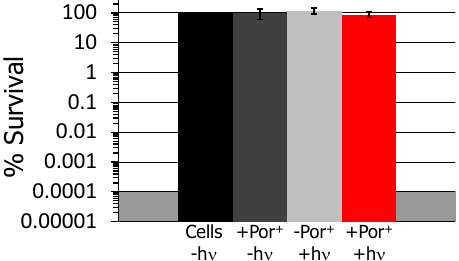
Figure 3. Photodynamic inactivation of Klebsiella pneumoniae using 50 nM Por (+) demonstrating that this photosensitizer (PS) concentration was unable to photoinactivate the bacterium. Displayed are the dark PS-free (cells-only) control set to 100% (black), the % survival of the dark control of Por (+) as a percent of the dark PS-free control (dark grey), the illuminated PS-free control as a percent of the dark PS-free control (light grey), and the illuminated Por (+) as a percent of the dark PS-free control (red). The illumination conditions and error bar visualizations were as described in Figure 2.